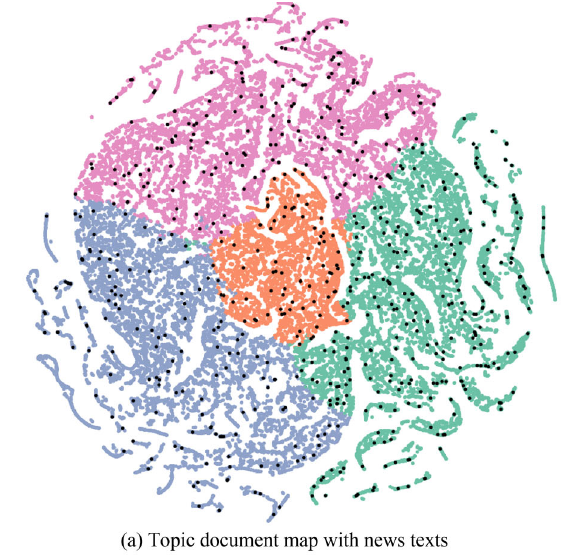
Fig. 5 Topic document map. (a) shows map label events as black dots in this view when users hover on red dots on the sentiment graph. (b) When users click on the dots in the scatter plot, the corresponding text is